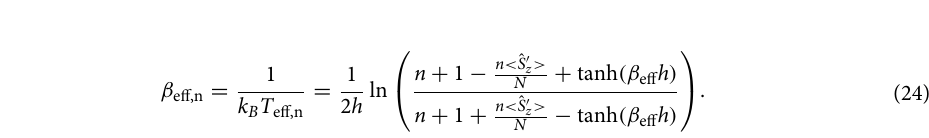
Figure 7. Ratio of the effective temperature of the ancilla qubits T eff = 1 / k B β eq,ancilla after turning off Ising interactions defined in Eq. (23) to the environment temperature T as a function of ( a ) interaction strength g with N = 6 and ( b ) number of ancilla qubits N with g = − h . We take h = 1